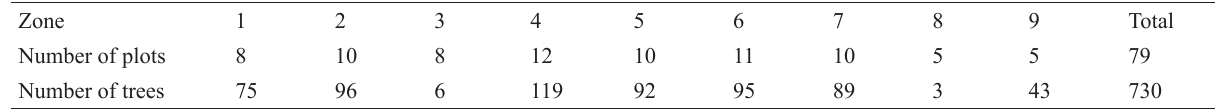
Table 1. Number of sampled trees per zone Zone